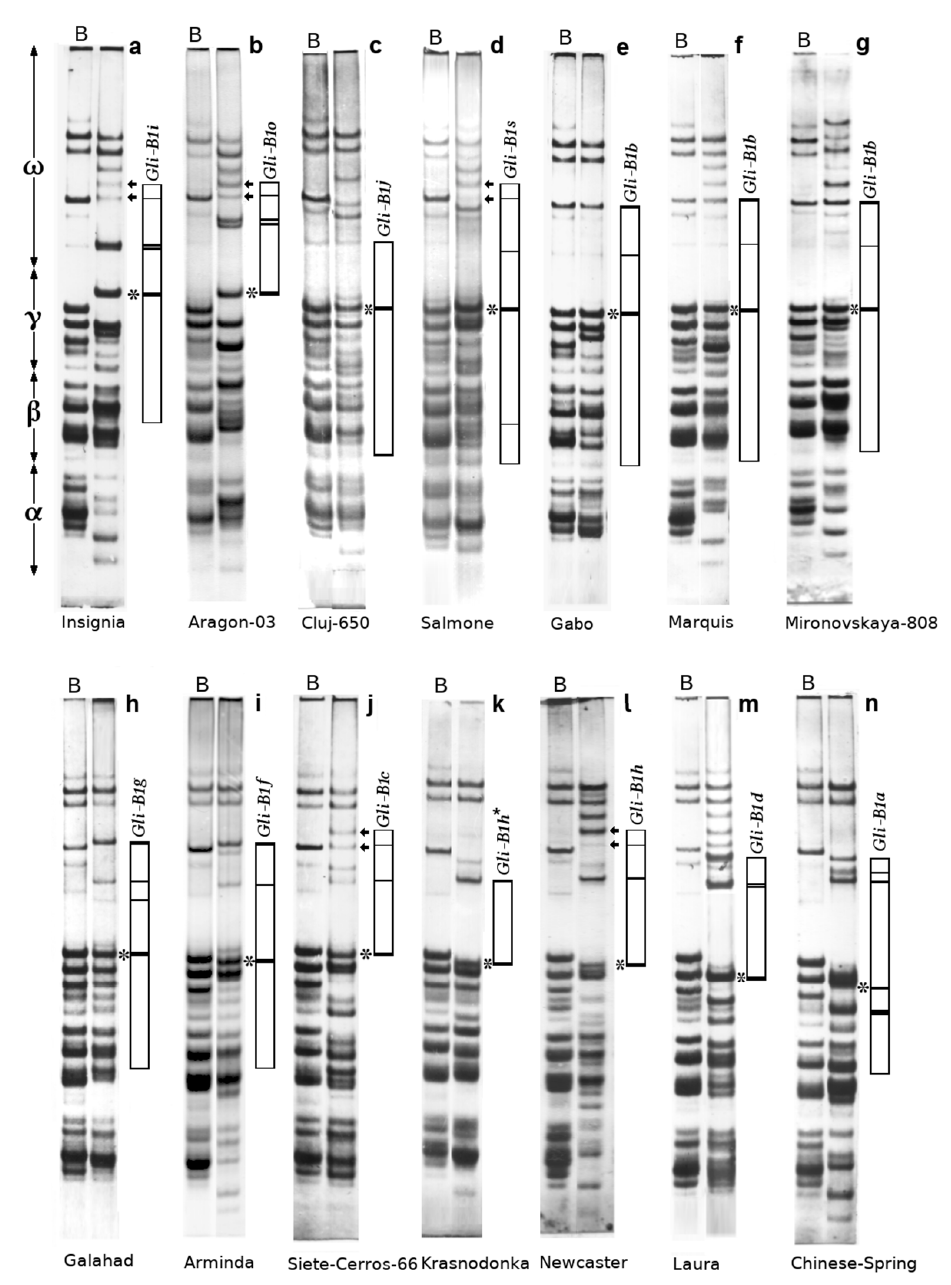
Gliadin electrophoregrams (APAGE) of some wheat cultivars studied. ( a ) Insignia; ( b ) Aragon-03; ( c ) Cluj-650; ( d ) Salmone; ( e ) Gabo; ( f ) Marquis; ( g ) Mironovskaya-808; ( h ) Galahad; ( i ) Arminda; ( j ) Siete-Cerros-66; ( k ) Krasnodonka; ( l ) Newcaster; ( m ) Laura; ( n ) Chinese-Spring. B, the cultivar Bezostaya-1. Blocks of jointly inherited gliadin electrophoretic bands are shown schematically. The major γ -gliadin (asterisk) and ω -gliadins encoded by the allele Gli-B5b (arrows) are indicated. *: see